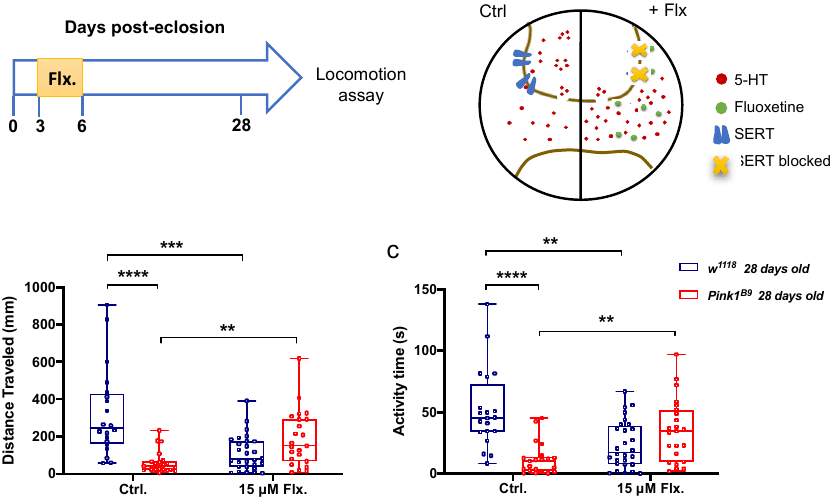
Figure 3. Effect of fluoxetine treatment on the locomotor behavior in 28-day-old Pink1 B9 mutant and control flies. ( a ). Left panel, a scheme for the timing of the fluoxetine (15 μ M) treatment. Right panel, a schematic representation of the pharmacological effect of fluoxetine treatment (right, +Flx) compared to the control situation (left, Ctrl). ( b , c ) Distance traveled (mm) and activity time (s), two locomotor parameters recorded in 28-day-old control and Pink1 B9 mutant flies treated or not with fluoxetine (15 μ M Flx and Ctrl, respectively). Data was obtained from n = 20 ( w 1118 ); 28 ( w 1118 + Flx); 21 ( Pink1 B9 ); 23 ( Pink1 B9 + Flx) flies. Data are presented as the interquartile range with maximum and minimum ranges. **, *** and **** indicate p < 0.01, p < 0.001 and p < 0.0001, respectively; Scheirer-Ray-Hare test followed by Dunn’s post hoc test.